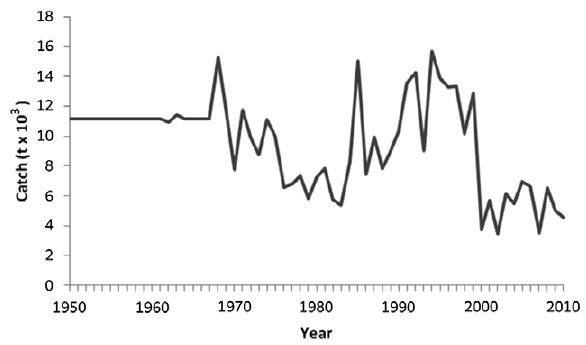
Fig. 6. – Tuna catch by the artisanal bait boat fleet in the Canary Islands,